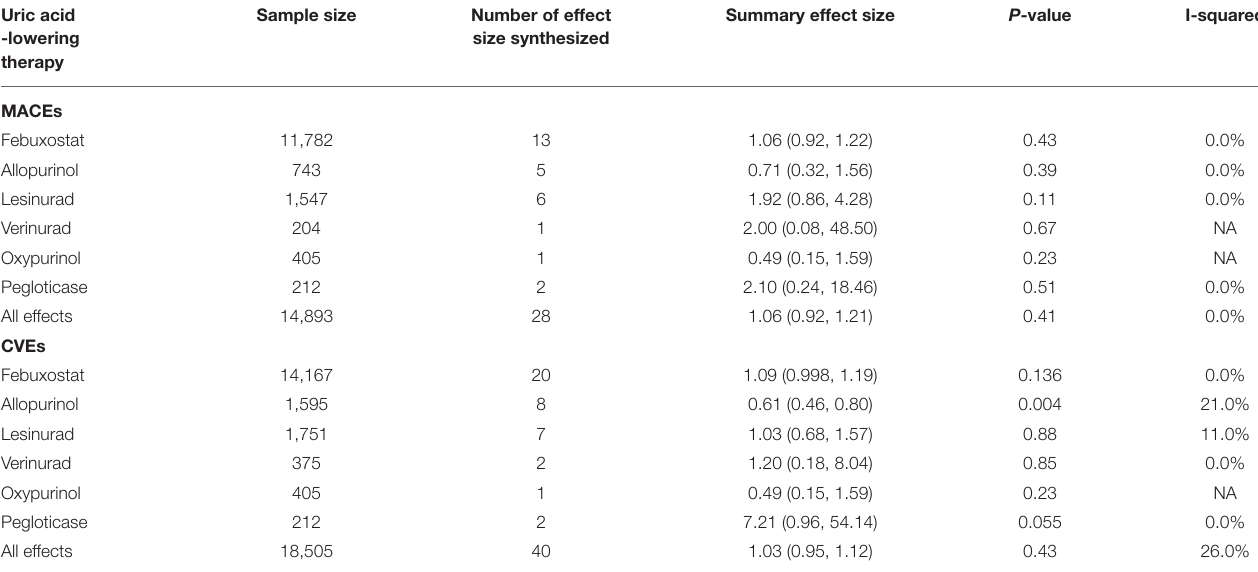
TABLE 1 | Meta-analysis of treatment effect of uric acid -lowering therapies on cardiovascular outcome.